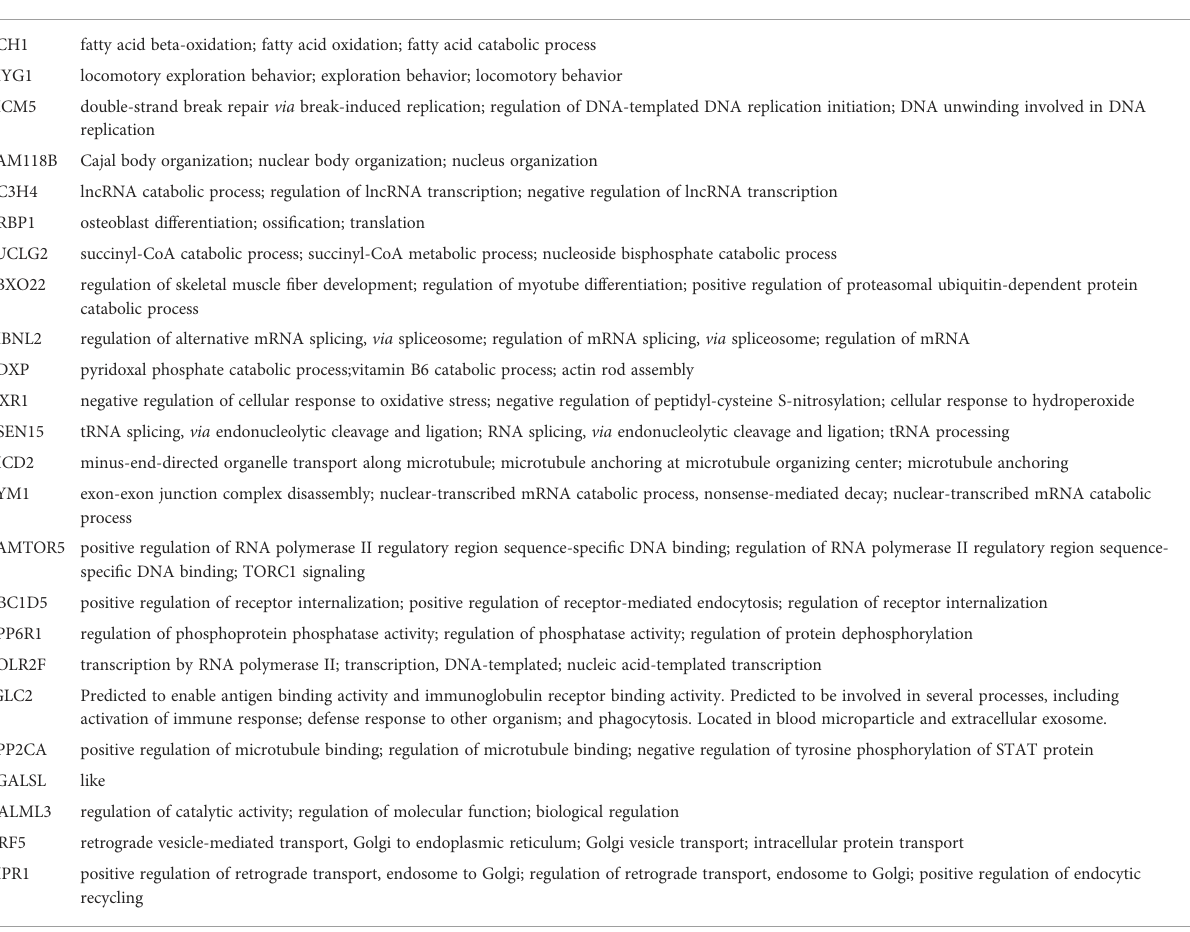
TABLE 4 Information of 24 types of shared proteins in CM -231 and CM-PC3. Gene